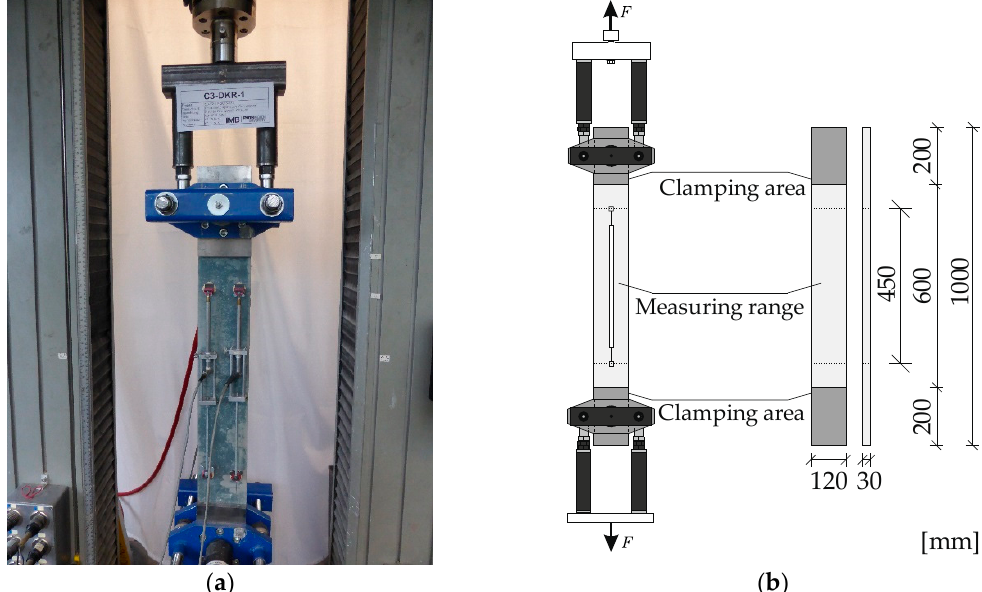
Figure 2. ( a ) Specimen in testing machine; ( b ) schematic (according to [10]) of the test setup for short-term tests.